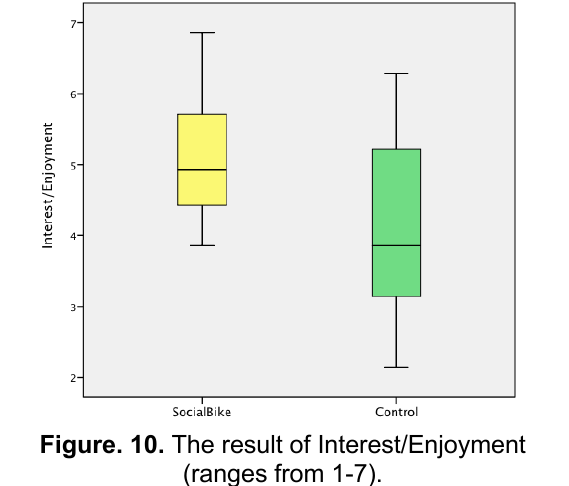
. Figure. 10. The result of Interest/Enjoyment (ranges from 1-7).